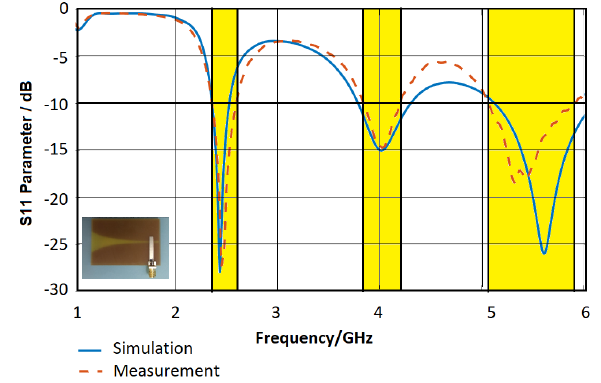
FIGURE 3. The simulation and measurement reflection coefficient of the proposed Vivaldi